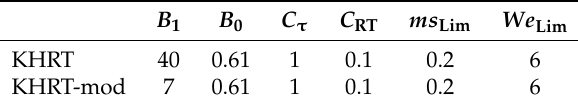
Table 2. KHRT model constants.